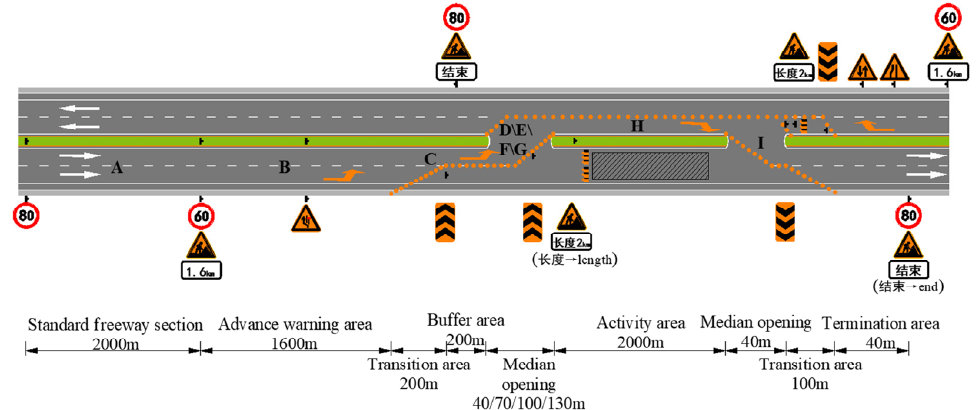
Figure 5. Details of each part of the experimental road.